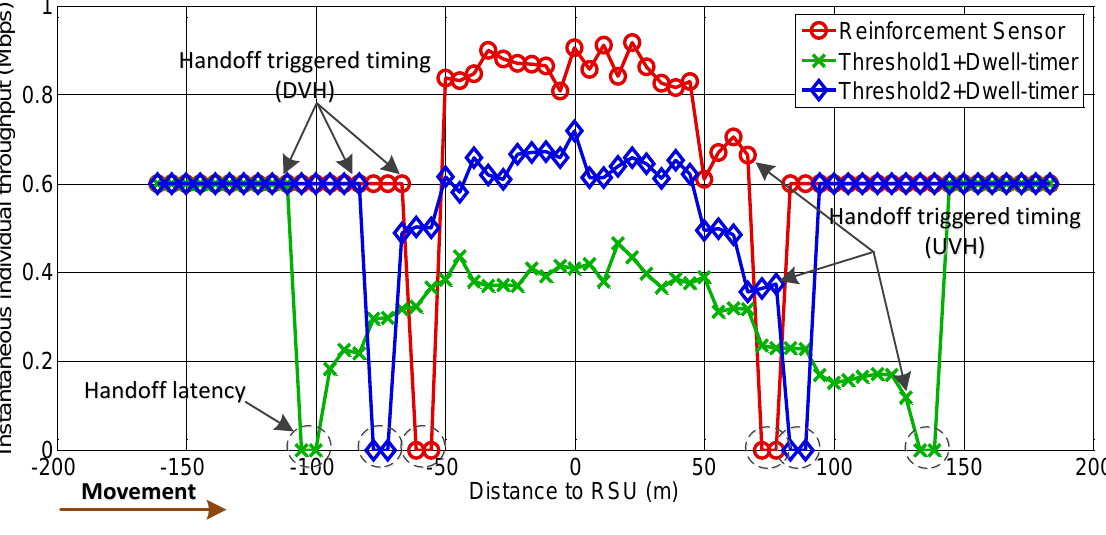
Figure 6. Instantaneous individual throughput vs. distance to RSU (arrival rate = 0.5 veh/s).